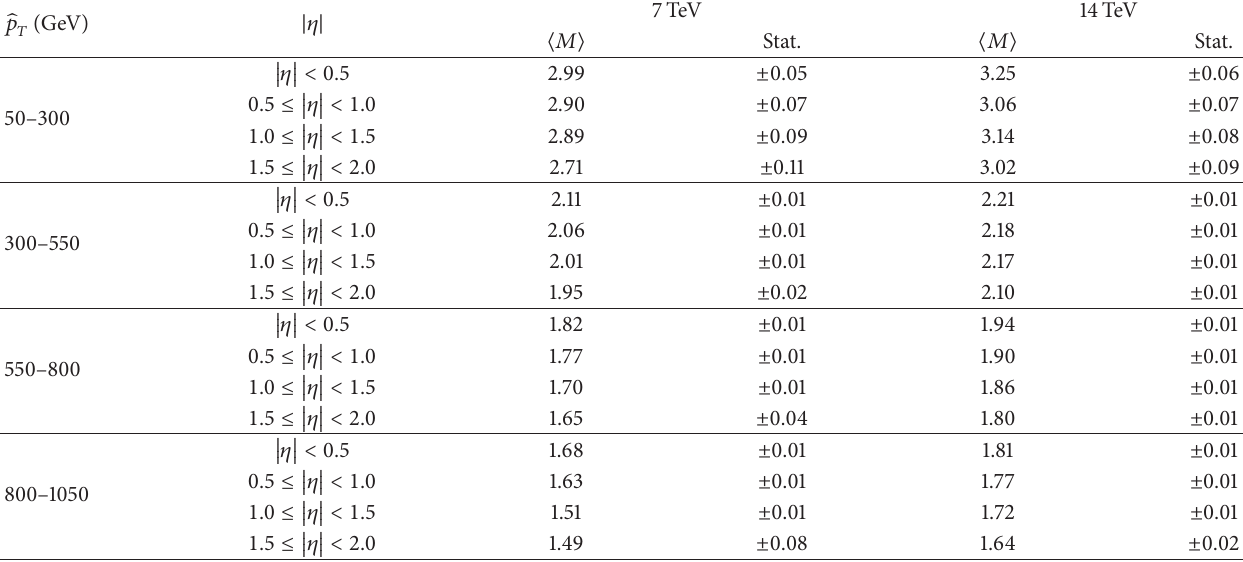
Table 2: Average subjet multiplicities as a function of |𝜂| in different ̂𝑝 𝑇 bins, for jets with 𝑃 jet 𝑇 > 100GeV for 𝑘 𝑇 algorithm at √𝑠 = 7TeV and √𝑠 =